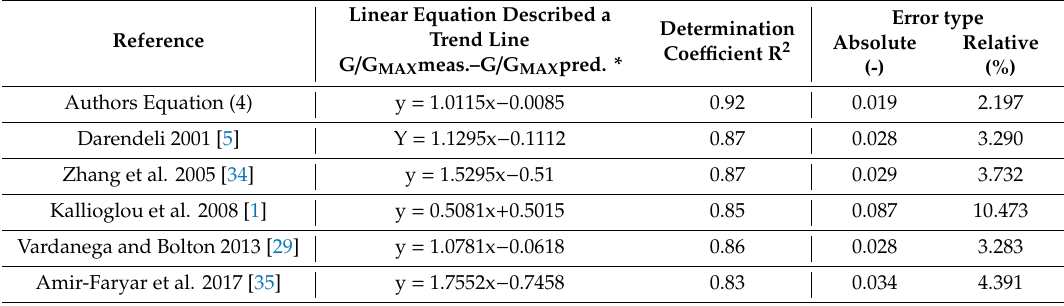
Table 7. Comparison between the author’s empirical model and purposed by [1,5,29,34,35].